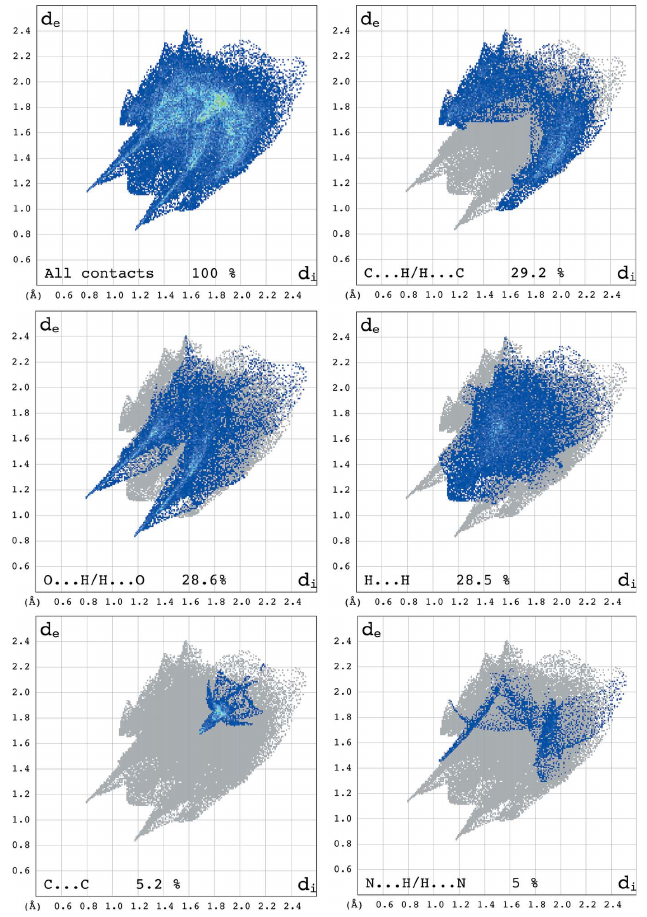
Figure 6 Two-dimensional fingerprint plots for (I), showing the contributions of all